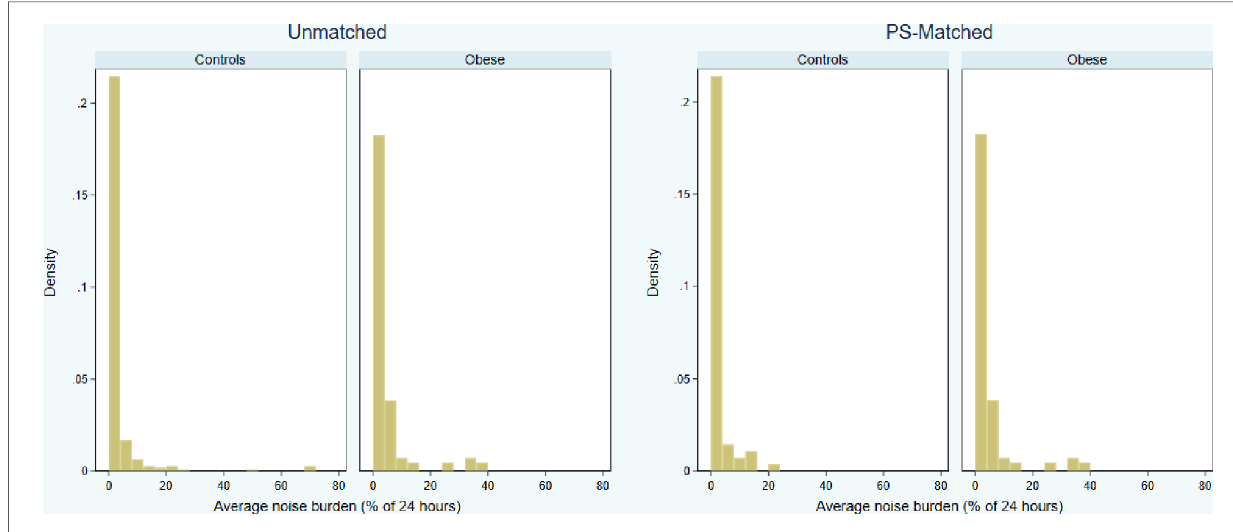
FIGURE 3 Distributions of 3-month average daily noise burden (percentage of 24 h) by study groups, in the unmatched and propensity score (PS) matched cohorts.